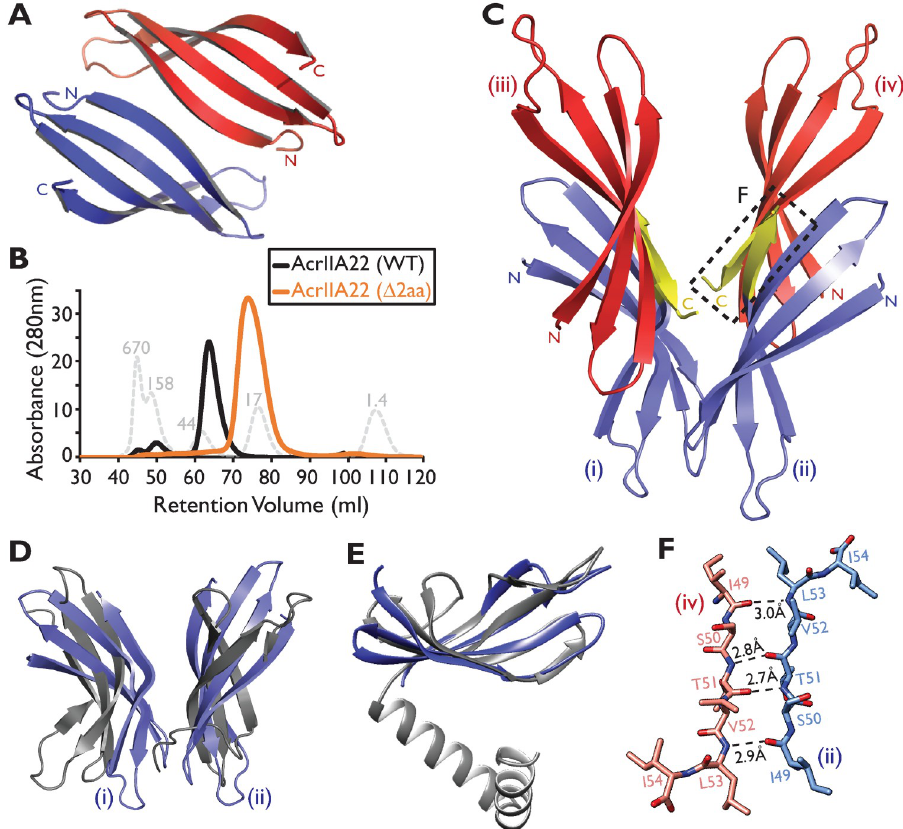
Fig 4. AcrIIA22 is an oligomeric PC4-like protein. ( A ) AcrIIA22’s crystal structure reveals a homodimer of 2 four- stranded β -sheets. ( B ) AcrIIA22 elutes as an oligomer that is approximately 4 times the predicted molecular mass of its monomer, which is 7 kDa. The gray, dashed trace depicts protein standards of the indicated molecular weight, in kDa. The orange trace depicts the elution profile of a 2-amino acid C-terminal AcrIIA22 truncation mutant that is predicted to disrupt oligomerization. ( C ) Ribbon diagram of a proposed AcrIIA22 tetramer, which requires binding between antiparallel β -strands at the C-termini of AcrIIA22 monomers to form extended, concave β -sheets. The putative oligomerization interface is indicated by the regions highlighted in yellow and the dashed box and is detailed further in panel F. Each monomer in the proposed tetramer is labeled with lowercase Roman numerals (i-iv). ( D ) β -sheet topology and orientation in AcrIIA22 (blue) resemble that of PC4-like family proteins (in gray, PDB:4BG7 from phage T5). ( E ) A monomer of AcrIIA22 (in blue, PDB:7JTA) is structurally similar to a PC4-like single-stranded DNA binding protein, which is proposed to promote recombination in phage T5 (in gray, PDB:4BG7, Z-score = 6.2, matched residues 15%), except for a missing C-terminal alpha helix. ( F ) A putative oligomerization interface between the C-termini of 2 AcrIIA22 monomers from panel (C) is shown in more detail. Dashed lines indicate potential hydrogen bonds between the polypeptide backbones. This interface occurs twice in the putative tetramer, between red- hued and blue-hued monomers in panel